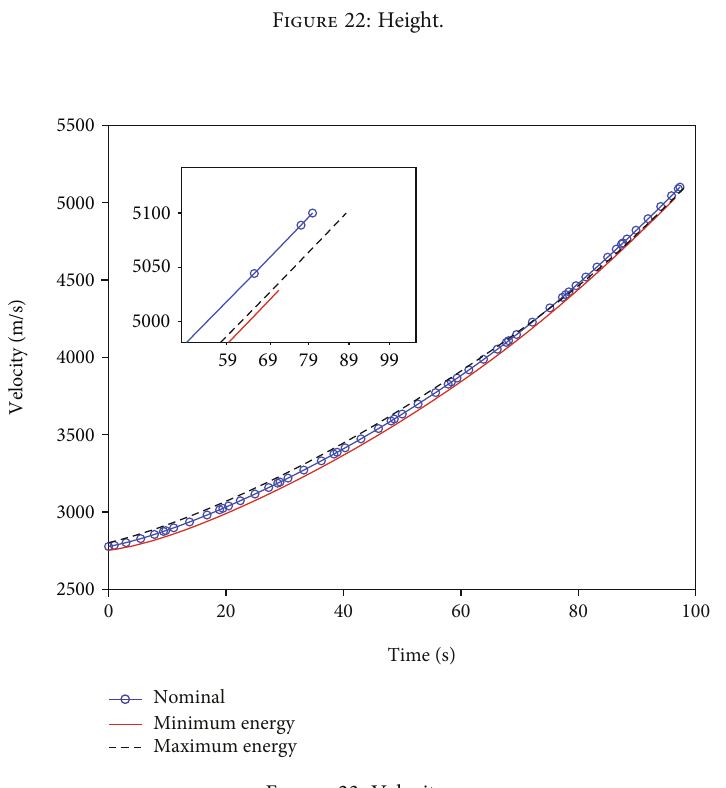
Figure 22: Height.